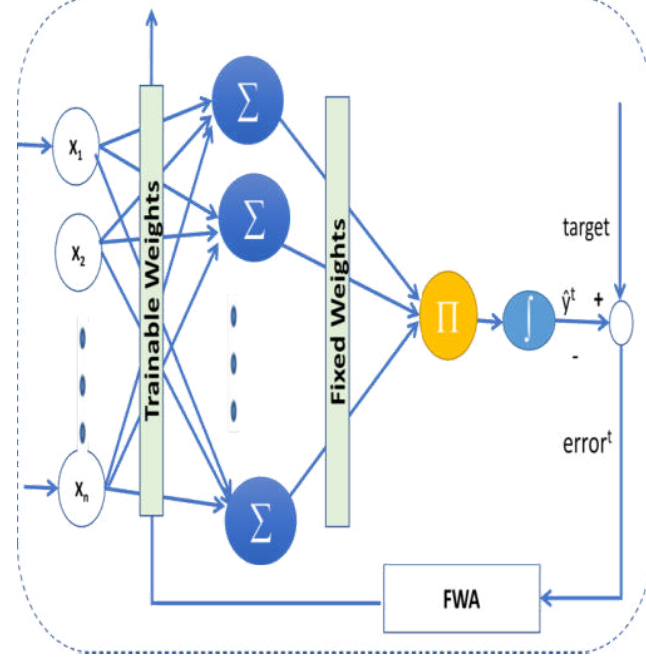
Figure 1 . FWA-PSNN based